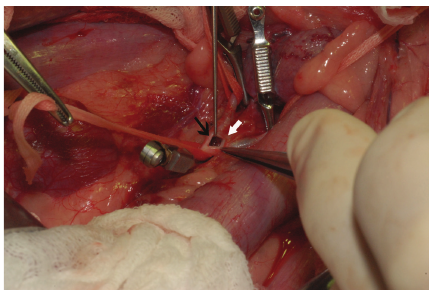
Figure 2: Intraoperative photograph of the aortotomy (black arrow). The cranial portion of the dog is to the left of the image. The thrombus is seen within the lumen of the aorta, just cranial to the aortic bifurcation (white arrow).